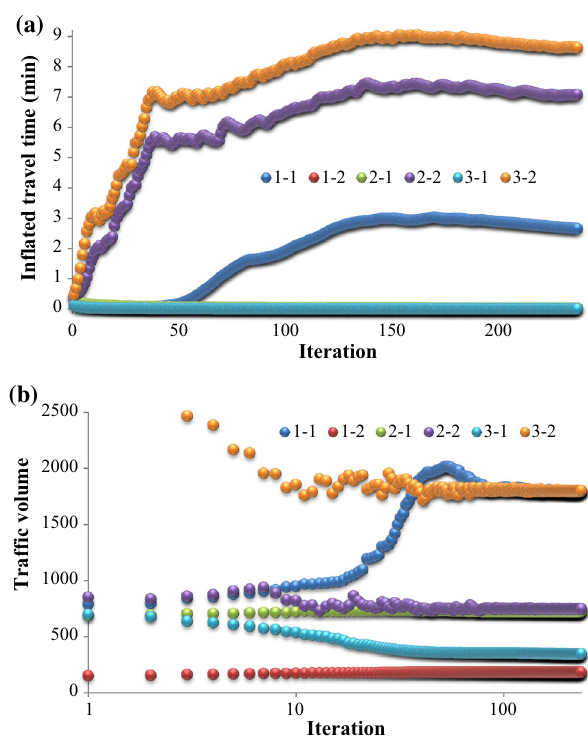
Fig. 5 Winnipeg case study, the first three bridges over successive iterations: a variation of the traffic volumes; b variation of the inflated travel